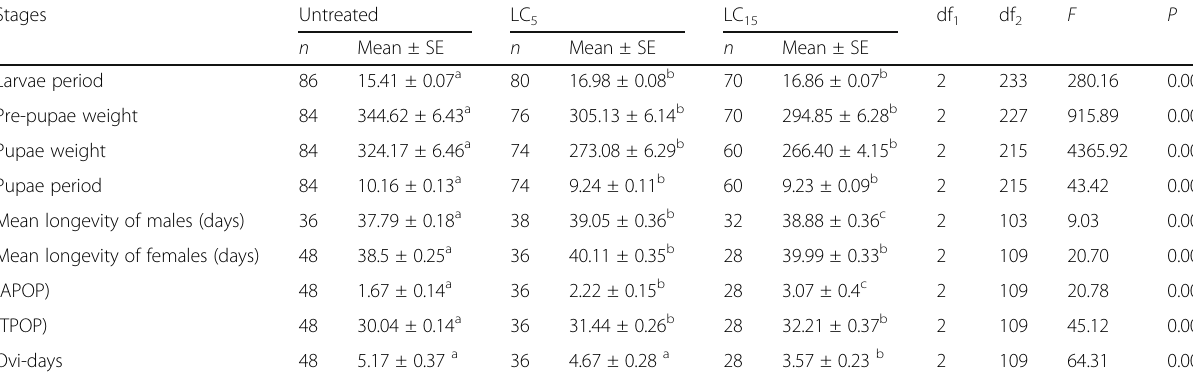
Table 2 Effect of emamectin benzoate (EMB) sublethal concentrations on various biological characteristics of Spodoptera littoralis